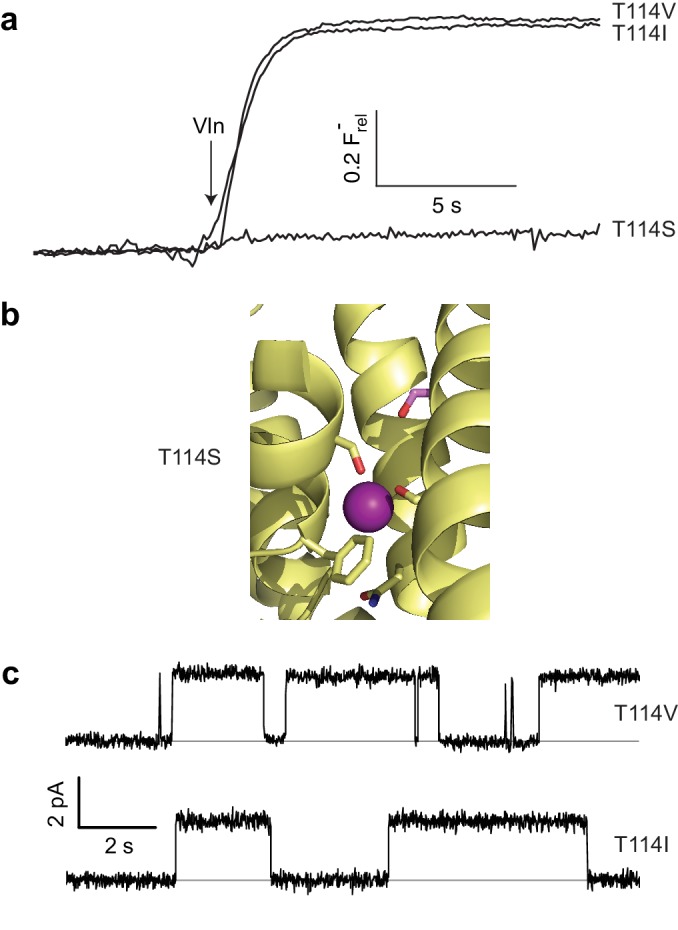
Unexpected T114 interaction.(a) Active and inactive T114 substitutions in F- efflux assay. (b) F--coordinating region of T114S crystal structure. Mutated residue is in pink. (c) Illustrative single-channel recordings of apolar substitutes scoring active in flux assay.